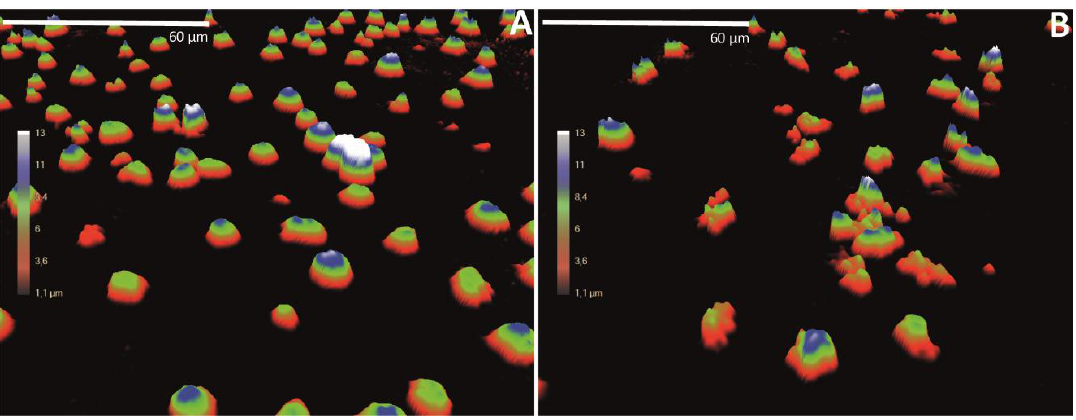
Figure 2. Jurkat cells cultured in ibidi chambers for 24 h: ( A ) Untreated cells; ( B ) Cells treated with 250 µM etoposide.